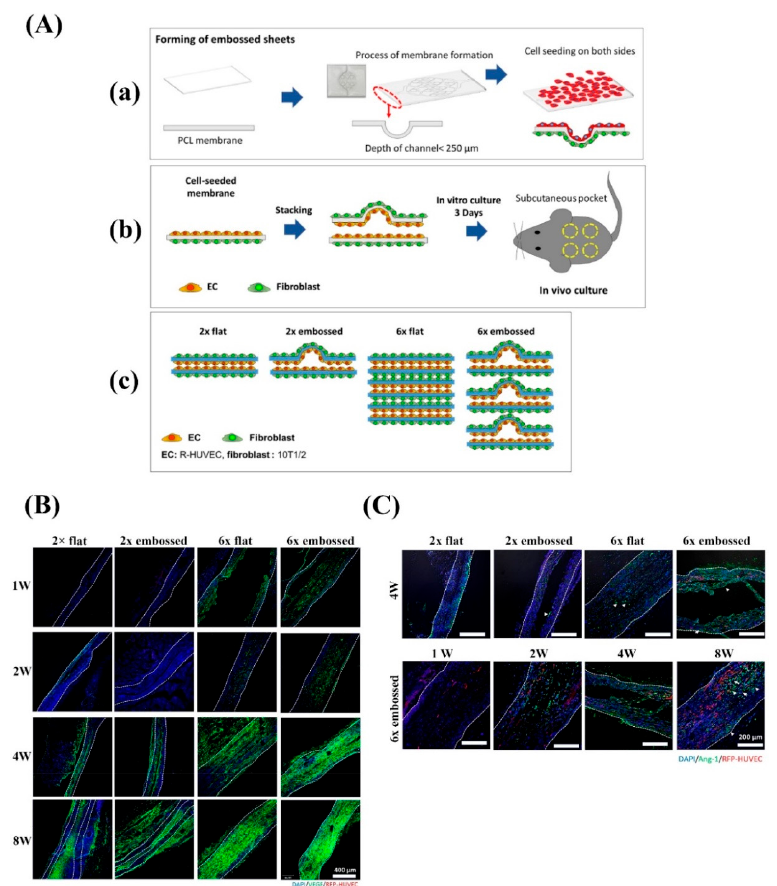
Figure 2. ( A ) A schematic representation of the preparation of electrospun nanofibrous membranes with embossed patterns for guided vascularization: ( a ) the formation of embossed sheet and plating of human ECs and mouse fibroblast cells, ( b ) stacking and incubating of the cell-laden sheets for 3 days before the implantation into subcutaneous pockets in mice, and ( c ) four different experimental groups evaluated in vivo. ( B ) Immunofluorescence images exhibiting differences in VEGF expression in different groups after 1, 2, 4, and 8 weeks of surgery; dashed lines show the edge of transplanted embossed sheets. Green: VEGF, red: human umbilical vein endothelial cell (HUVEC), blue: DAPI. ( C ) Immunofluorescence images exhibiting differences in angiopoietin 1 (Ang-1) expression in cross- sections of different groups after 1, 2, 4, and 8 weeks of surgery; dashed lines show the edge of transplanted embossed sheets. Green: Ang-1, red: HUVEC, blue: DAPI (adapted from Hong et al. [204] ). PCL, poly( ε -caprolactone); EC, endothelial cell.